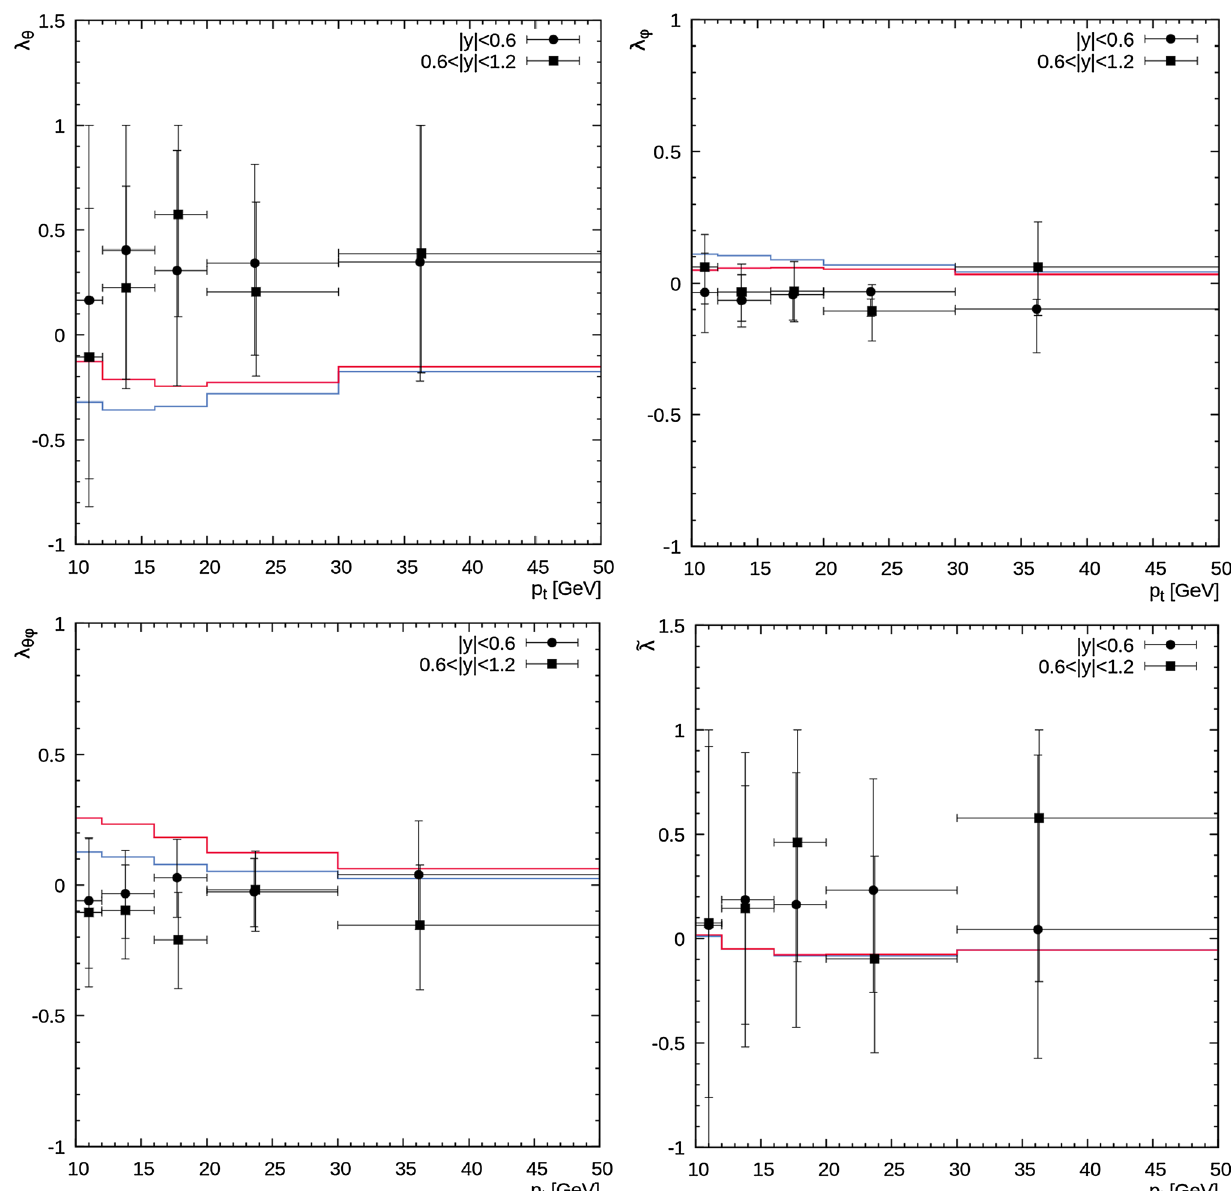
Fig. 8 The polarization parameters λ θ , λ φ , λ θφ and ˜ λ of ϒ( 3 S ) mesons calculated in the helicity frame as function of its transverse momentum at √ s = 7 TeV. Notation of all histograms is the same as in Fig. 7. The experimental data are from CMS [29] ˜ λ = (λ independent parameter θ + 3 λ φ )/( 1 − λ φ ) has